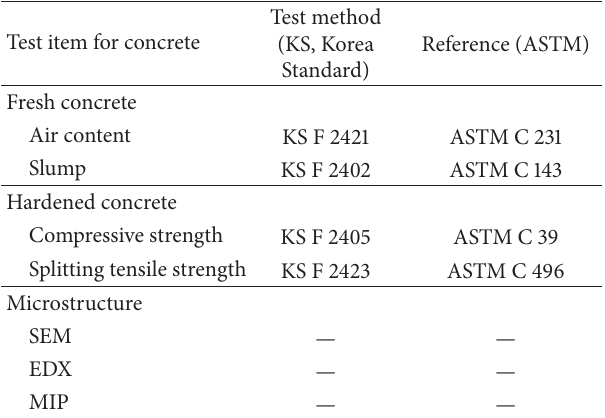
Table 4: Test method for concrete with